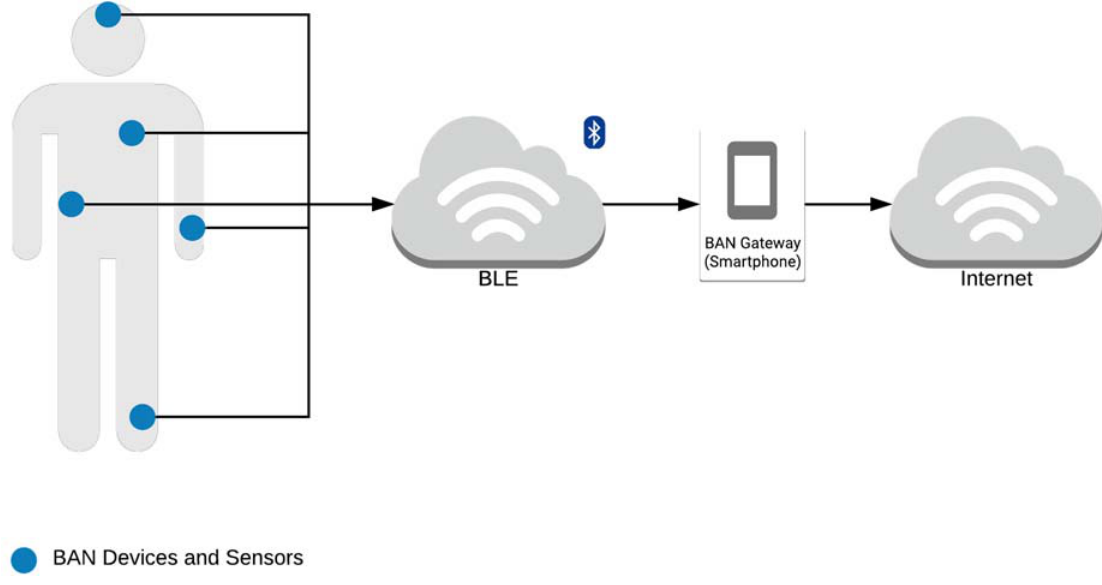
Figure 3. SmartWalk Body Area Network (BAN).